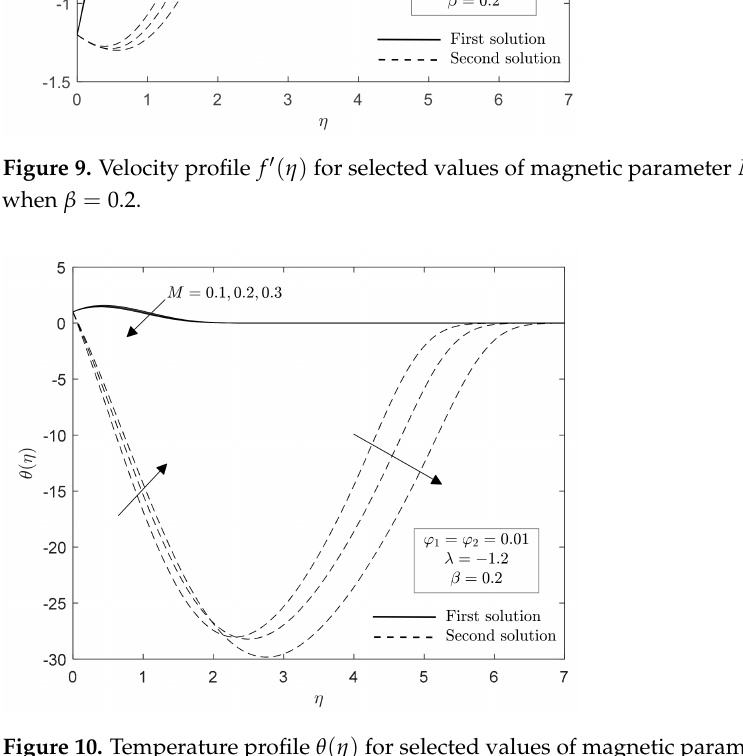
Figure 10. Temperature profile θ ( η ) for selected values of magnetic parameter M (Shrinking sheet case) when β = 0.2.